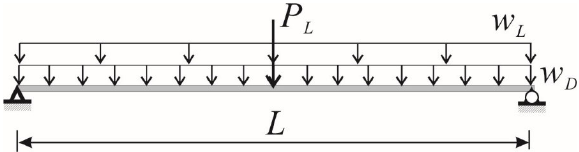
Fig. 4. A simply supported RC rectangular beam under dead and live